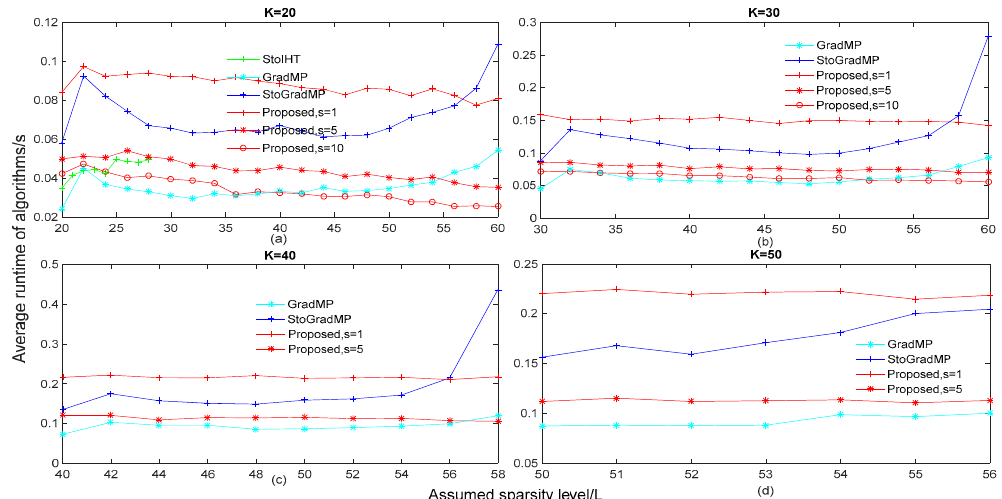
Figure 7. The average runtime of different algorithms with different sparsities in different sparsity conditions. ( n = 400, s ∈ [ 1,5,10,15 ] , δ K = 0.1 and m = 170, Gaussian